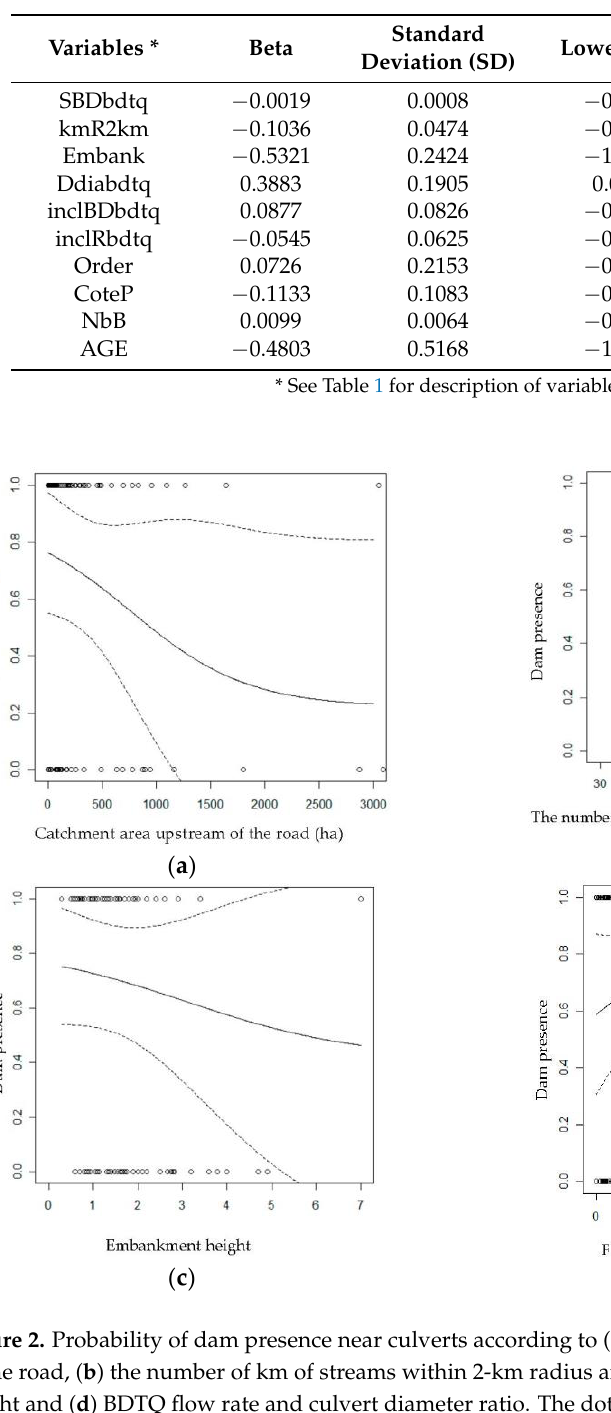
Table 4. Results of multi-model inference for the variables included in the top two models (HYDRO2, ANTROPHO).